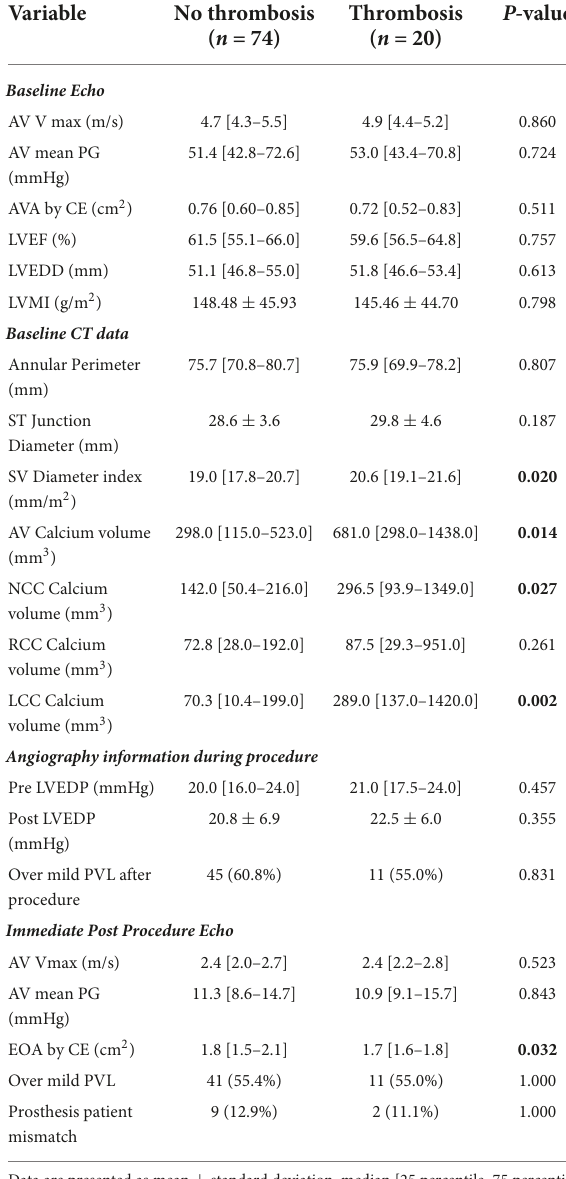
TABLE 2 Values of imaging comparison between the no leaflet thrombosis and the leaflet thrombosis